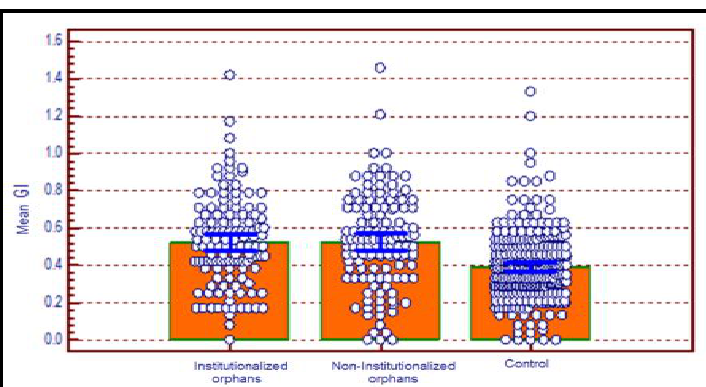
Figure 2: Dot diagram with error bars showing the difference among the 3 groups in mean (with its 95% confidence interval) PLI.